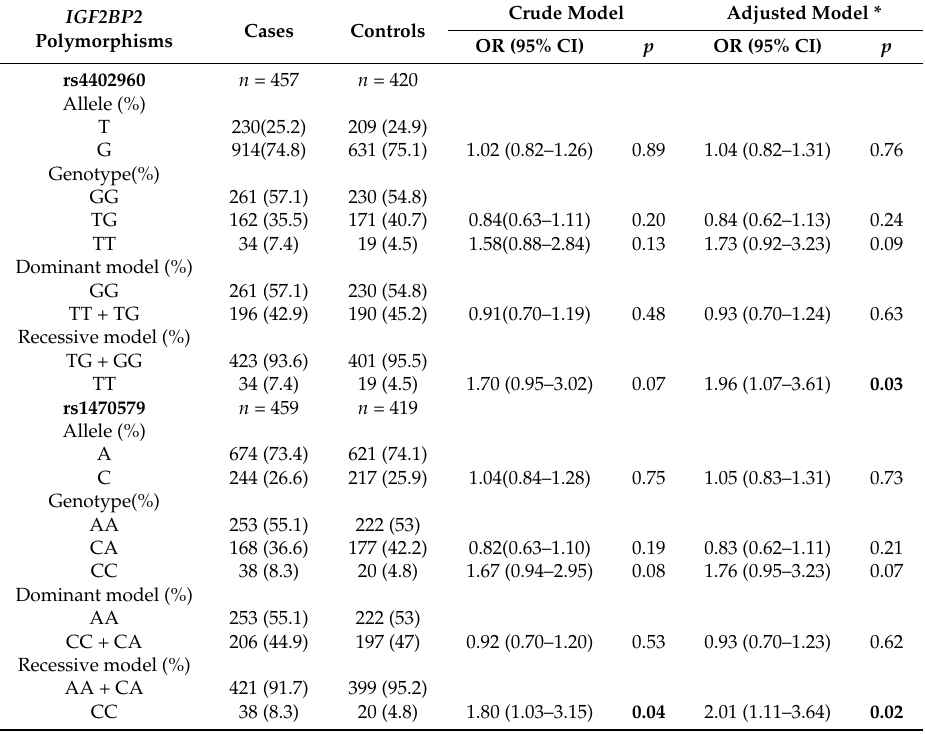
Table 2. Genotype and allele frequencies of the SNPs in patients with T2DM and healthy controls. IGF2BP2